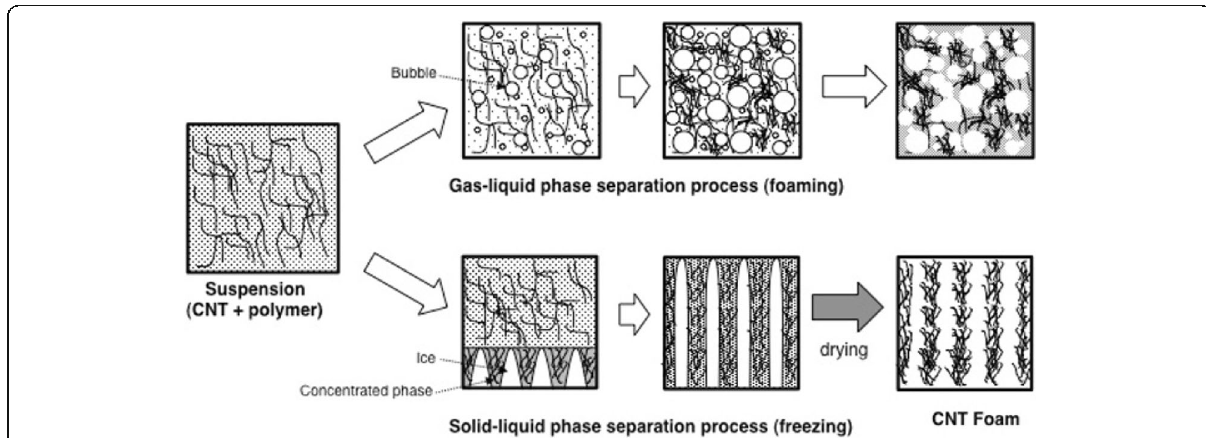
Fig. 36 CNT foam formation using various techniques. The figure depicts various phase separation processes being performed on a CNT suspension to produce the CNT foam. The phase separation process is usually done via a gas-liquid phase separation or a solid-liquid phase separation as shown in the figure. Adapted from [258]